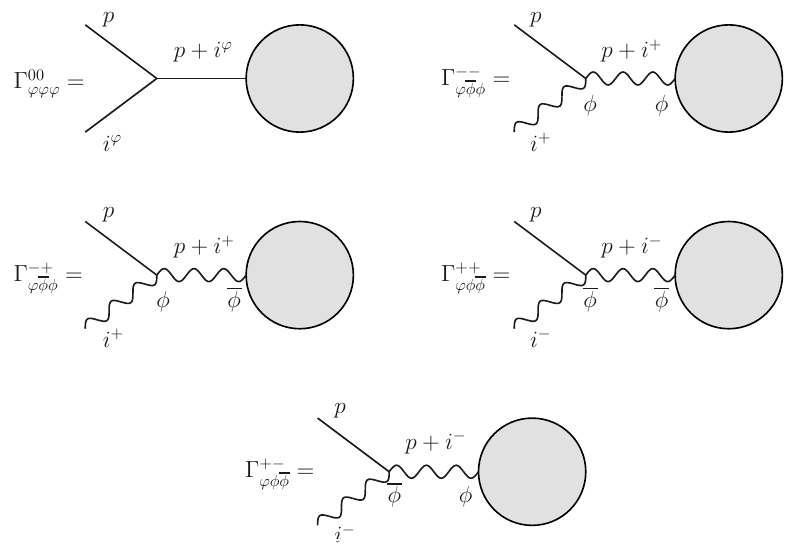
Figure 2 . The graphs with a nontrivial single scalar soft